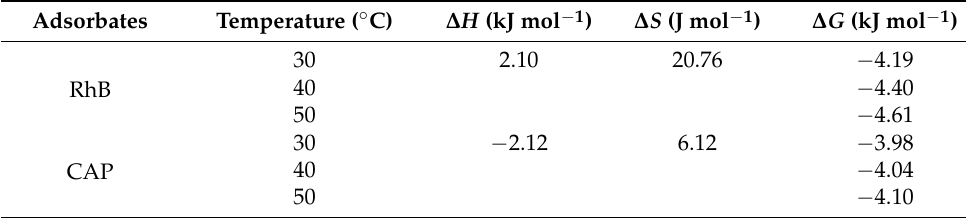
Table 4. Thermodynamic parameters for adsorption of PCAC toward RhB and CAP.